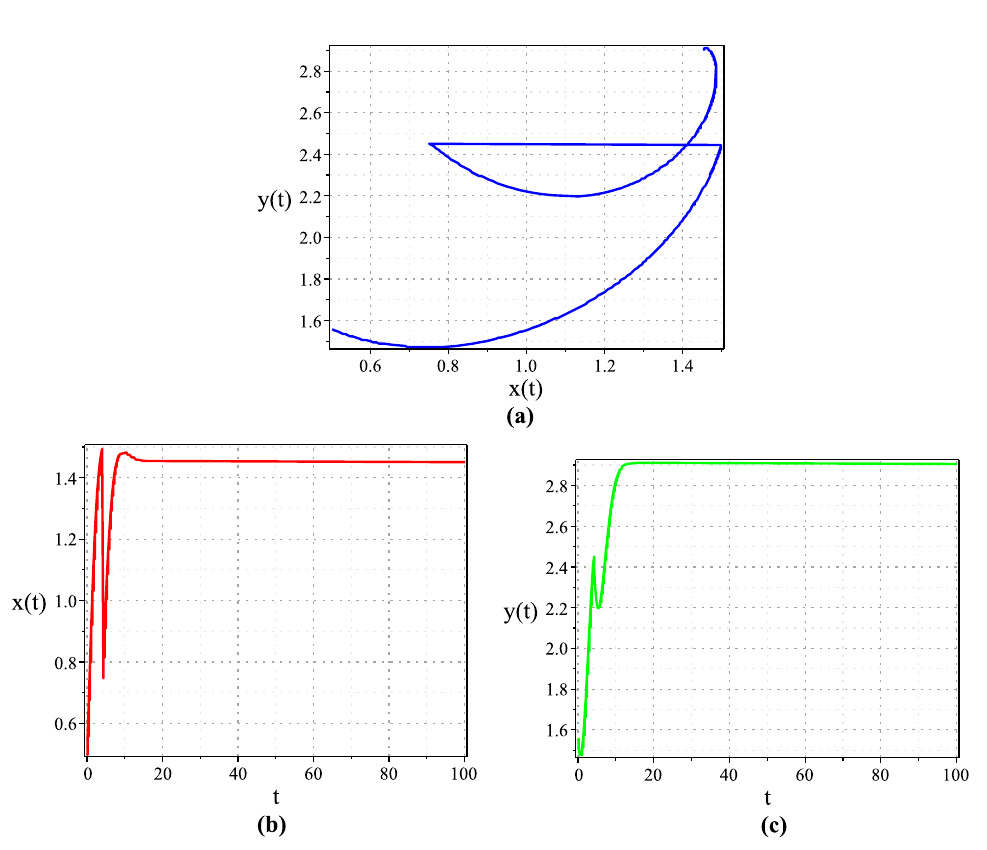
Figure 6. Phase portrait and time series of system (7) with h = 1.5, v = 0.5. ( a ) Phase portrait of x(t) and y(t). ( b ) Time series of x(t). ( c ) Time series of y(t). We assume r = 1.5, K = 25, D = 2, b = 0.1, a = 0.5, h = 4, v = 0.5 and pest initial value x ( t ) = 2.